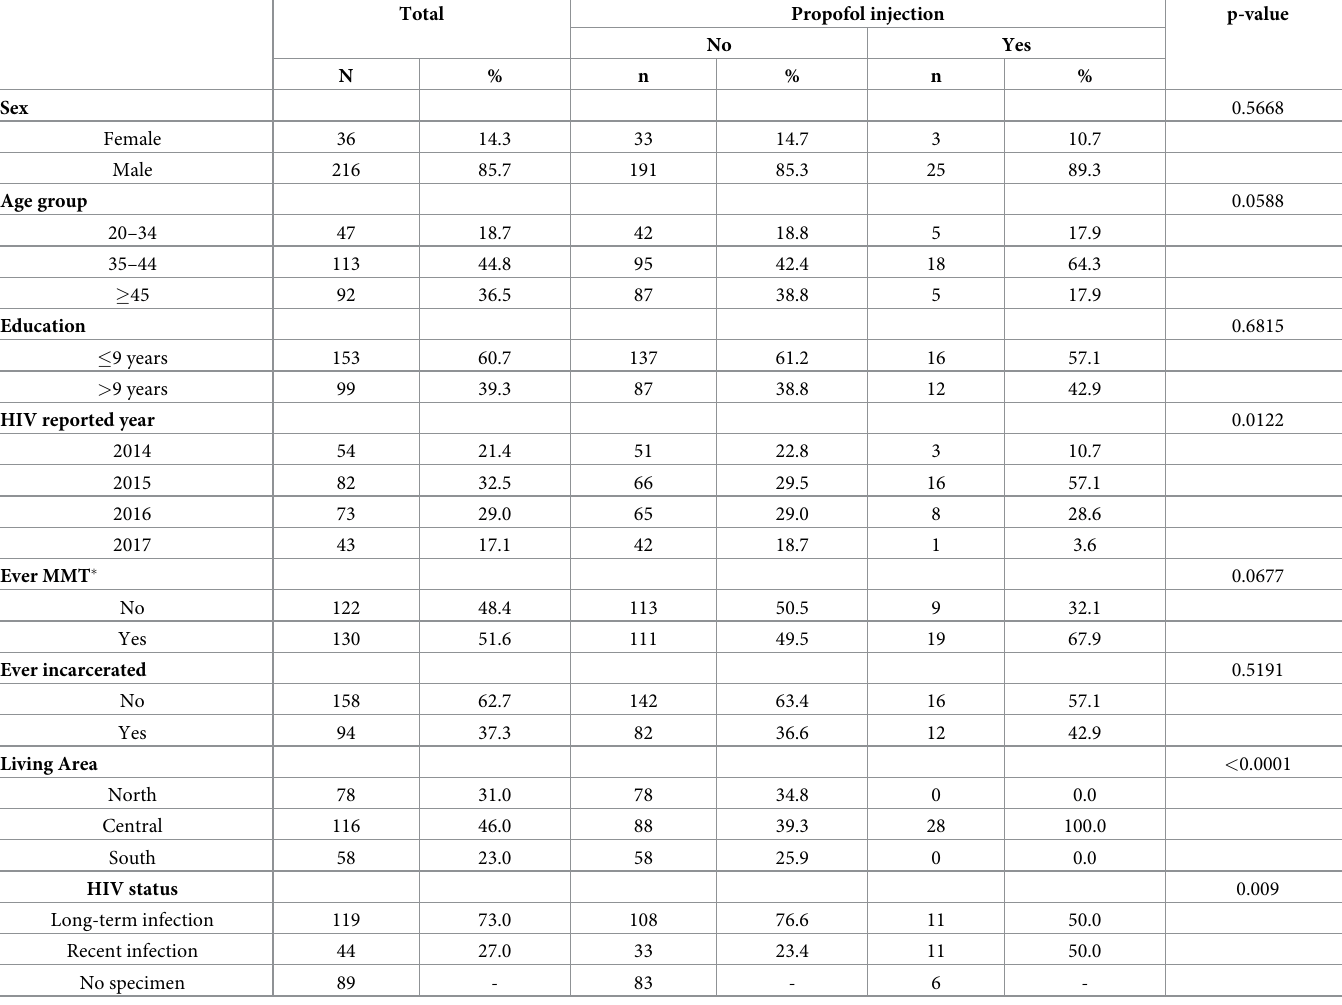
Table 1. Characteristics of people who inject drugs (PWID) enrolled in the study cohort (N =